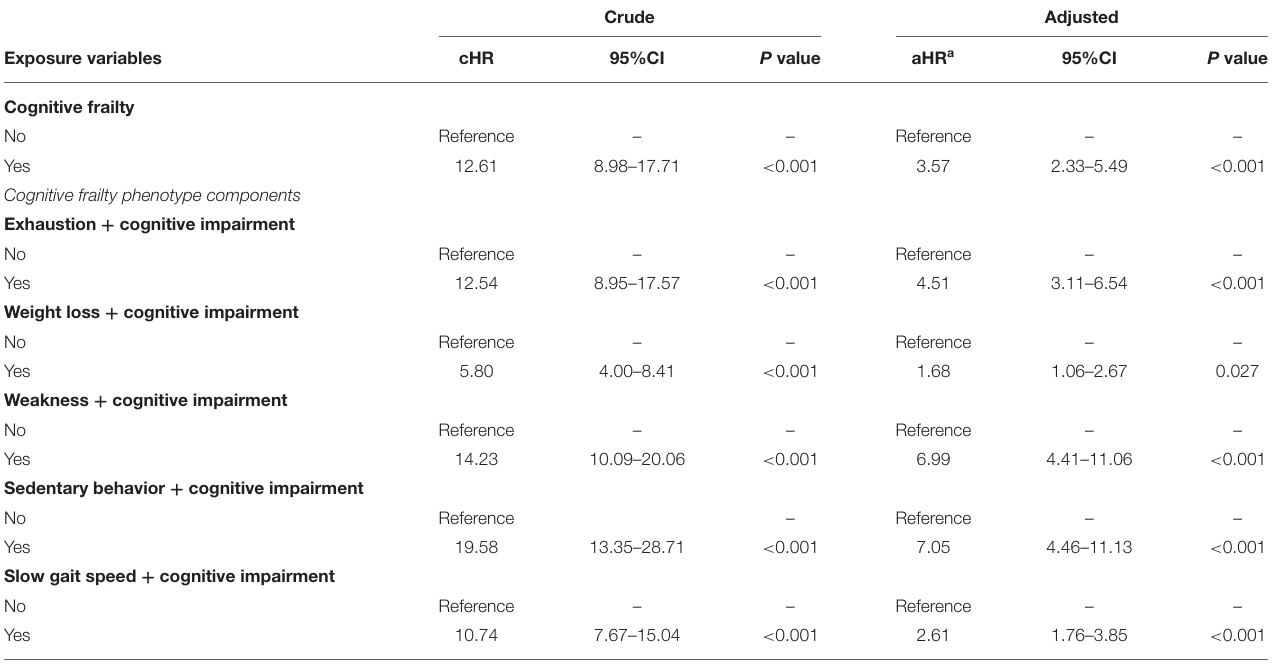
TABLE 3 | Cox regression models to evaluate the association between the cognitive frailty phenotype and the risk of mortality in the study sample.